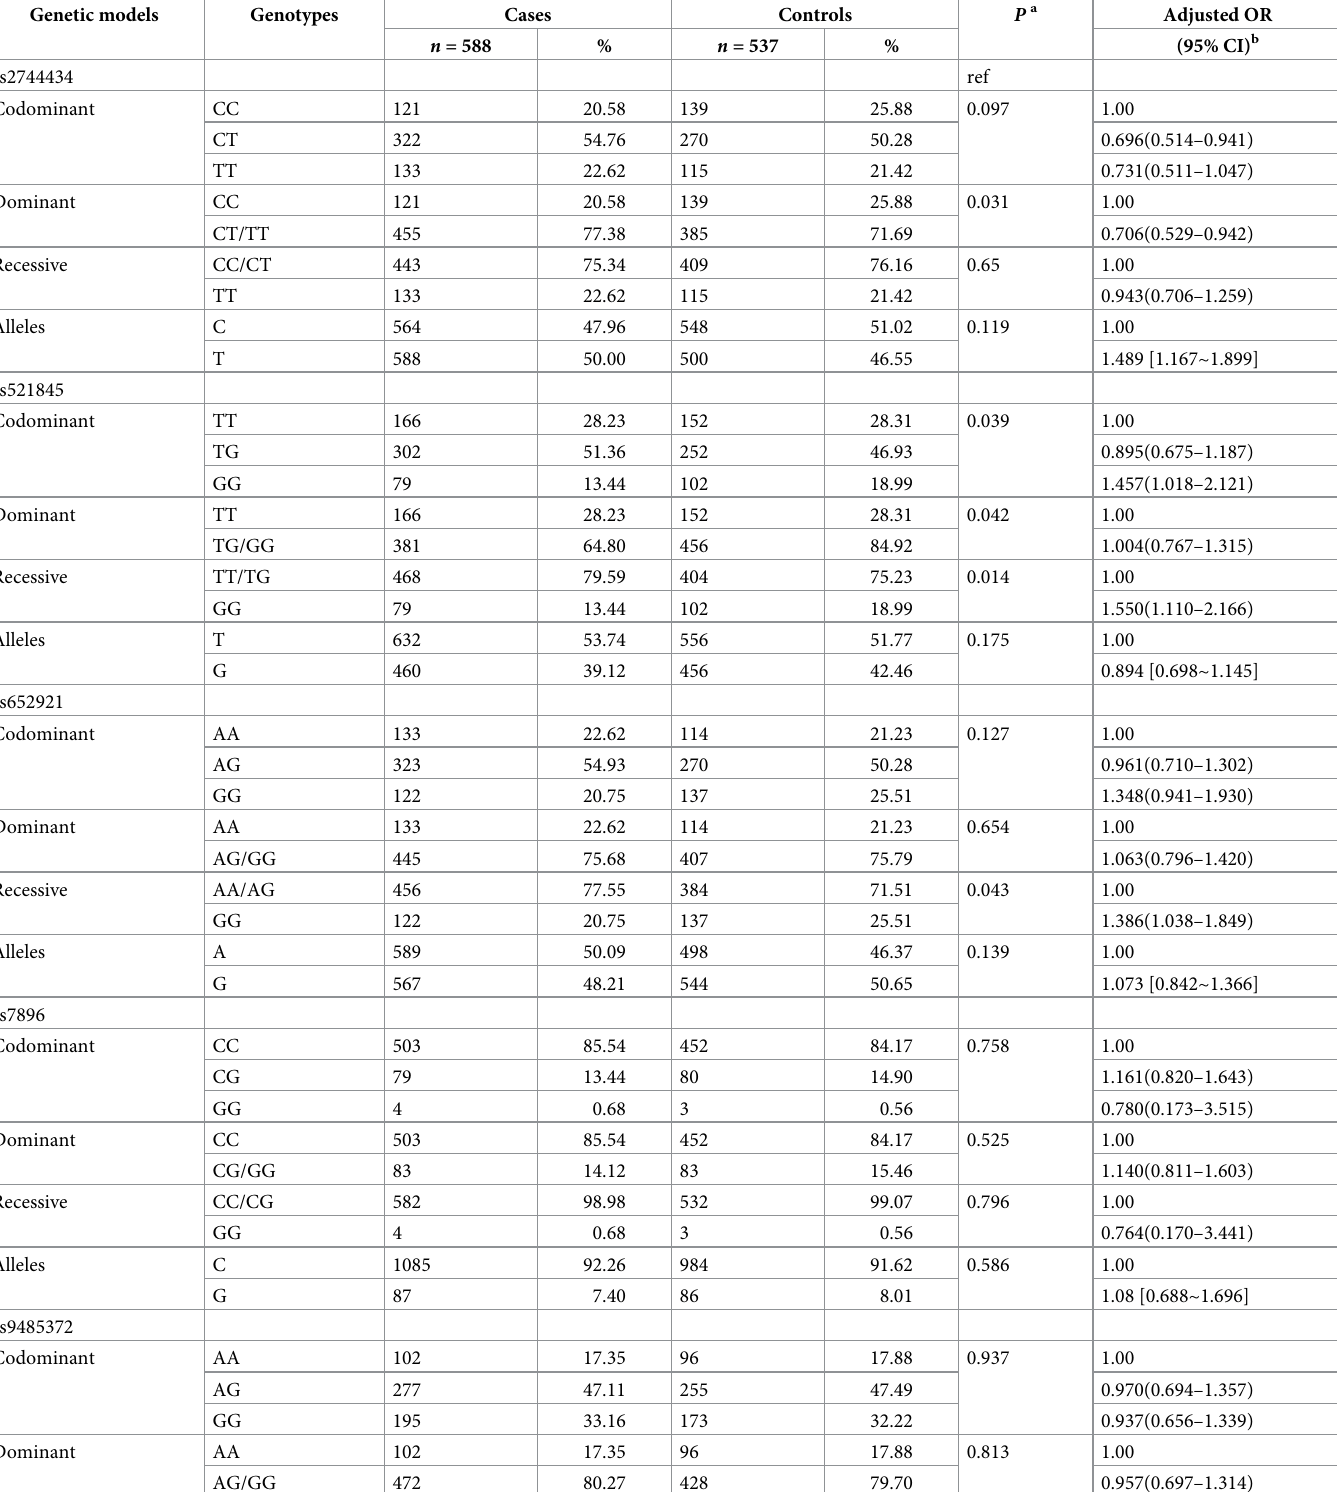
Table 3. Distribution of five polymorphisms and the association with NIHL. Genetic